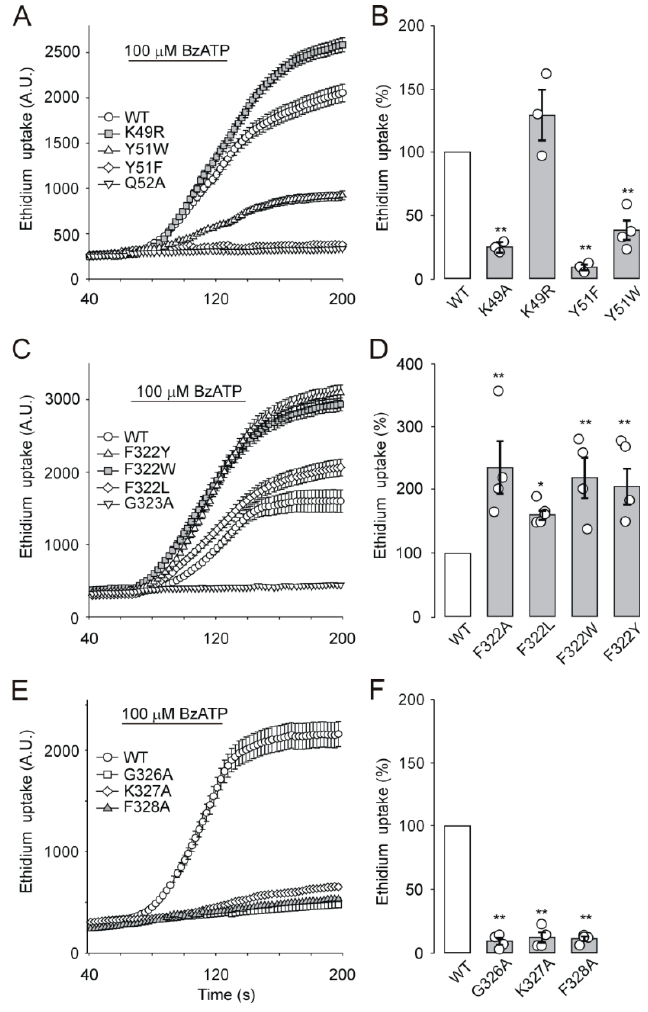
Figure 5. BzATP-stimulated EtBr accumulation by cells expressing the WT and mutant P2X7 receptors. ( A , C , E ) Example experiment showing fluorescent measurement of EtBr uptake by HEK293T cells expressing WT (open circles) and mutant P2X7 receptors. EtBr accumulation was triggered by 100 µ M BzATP (horizontal bar), and dye uptake was determined as the amplitude of the EtBr signal 100 s after the beginning of the BzATP application. Signals from 5–10 cells were averaged, and the data points are the means ± SEMs. The intensity of light emission was measured every 1–2 s; for clarity, some data points have been omitted. A.U., arbitrary units. Example of 3–7 similar experiments. ( B , D , F ) Summary histograms showing the BzATP-stimulated EtBr uptake (in % of control) by cells expressing the WT receptor (white column) and mutant P2X7 receptors. Data are presented as the means ± SEMs of 3–7 experiments; statistical significance was estimated by using one-way ANOVA followed by post-SNK test; p < 0.05 (*) and p < 0.01